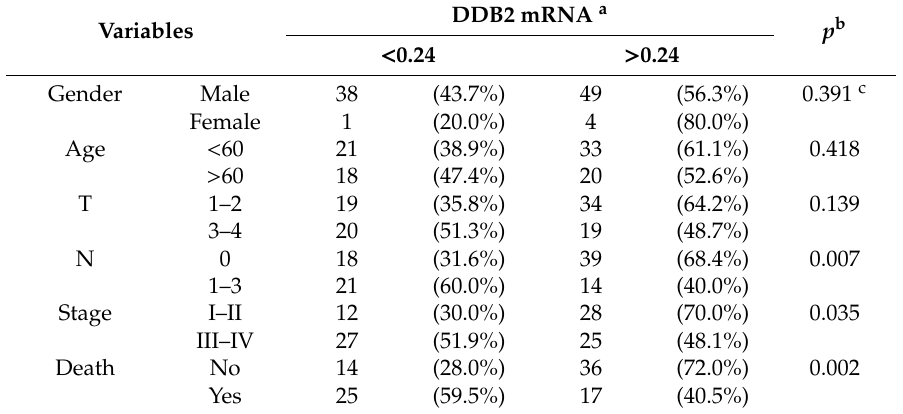
Table 1. Correlation between clinicopathological variables and DDB2 mRNA